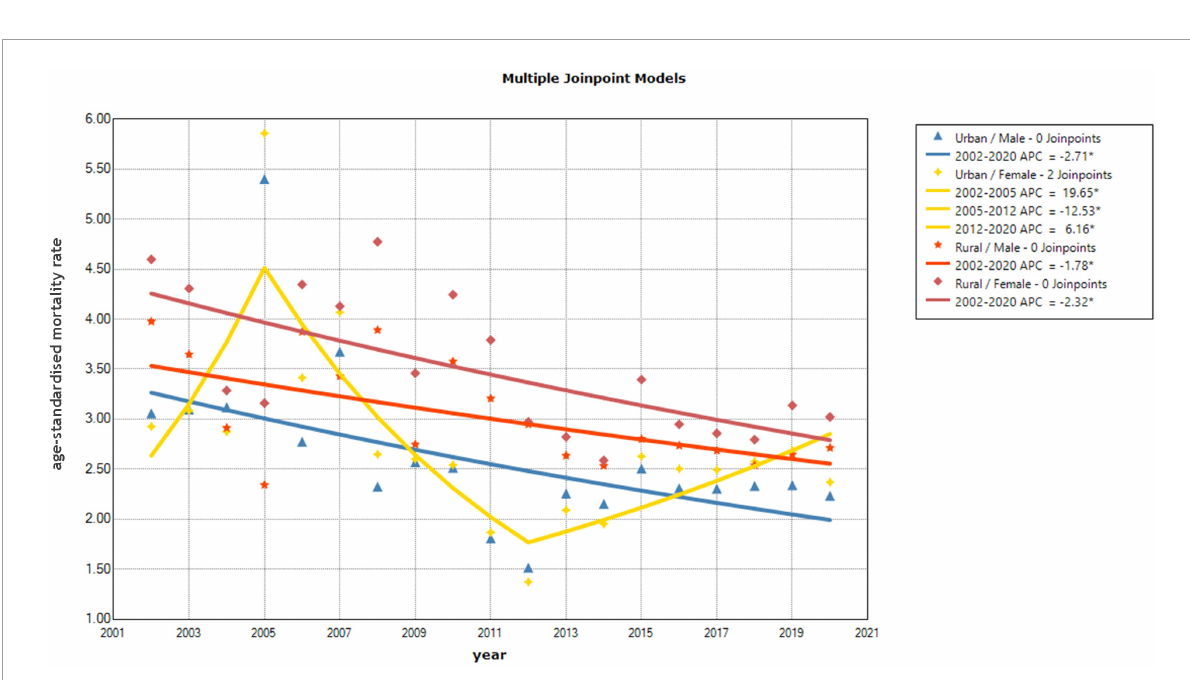
FIGURE2 Annual percentage change (APC) in the trend of age-standardized mortality rates for Chinese residents by gender from 2002 to 2020.